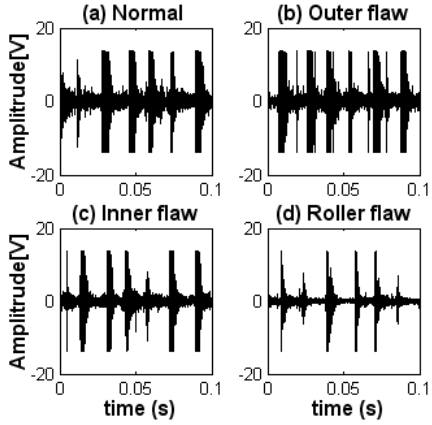
state. (c) Inner-race flaw state. (d) Roller flaw state.